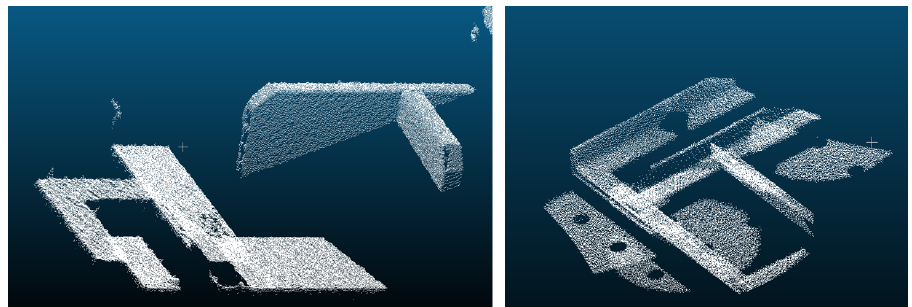
Figure 3. A real point cloud taken by an Ensenso N35 ( left ) and a simulated pointcloud ( right